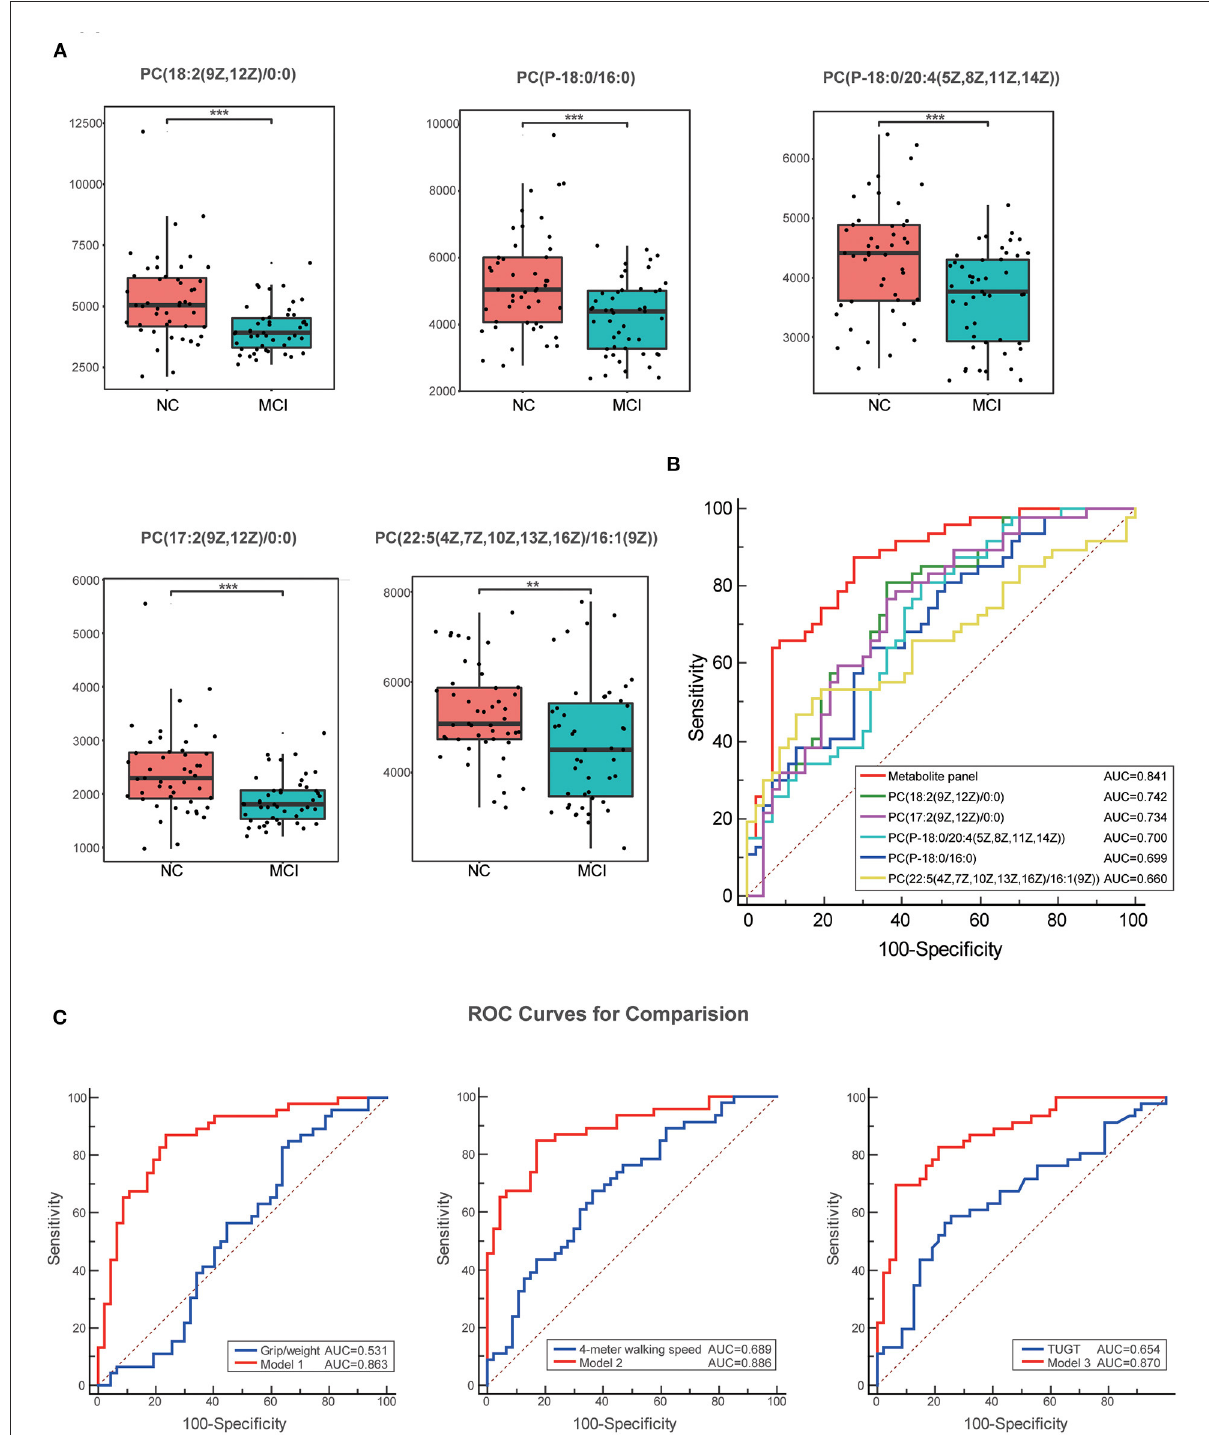
FIGURE3 Box plots and the ROC curves for the most significantly varied differential metabolites. (A) Box plots show the significant changes in metabolite levels of the first five PCs. Data were expressed as means ± SE. ** indicates p < 0.01, *** indicates p < 0.001. (B) The ROC curves of the metabolite panel and each metabolite to discriminate MCI from the NC groups. (C) Comparison of the ROC curves for physical performance combined with metabolites with single physical performance tests. These combined metabolite panels showed satisfactory diagnostic performance for distinguishing MCI from NC. Model 1 includes grip/weight plus metabolites, the AUC = 0.863; model 2 includes walking speed plus metabolites, the AUC = 0.886; and model 3 includes TUGT plus metabolites, the AUC = 0.870. ROC, the receiver operating characteristic; TUGT, Timed Up and Go Test; MCI, mild cognitive